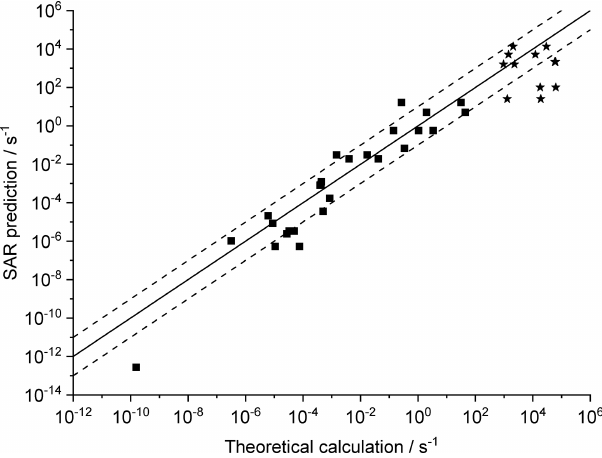
Figure 6. Theory-based k (298K) rate coefficients for multi- functionalized RO 2 compared against the SAR predictions. The solid line shows 1 : 1 correspondence, with the dotted lines delin- eating an order of magnitude of